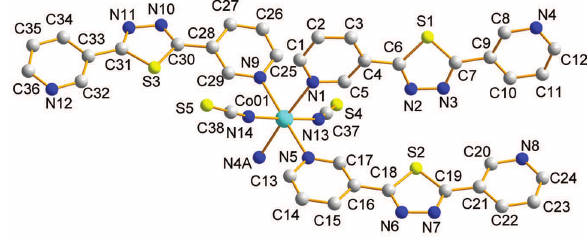
Table 1: Data collection and handling.